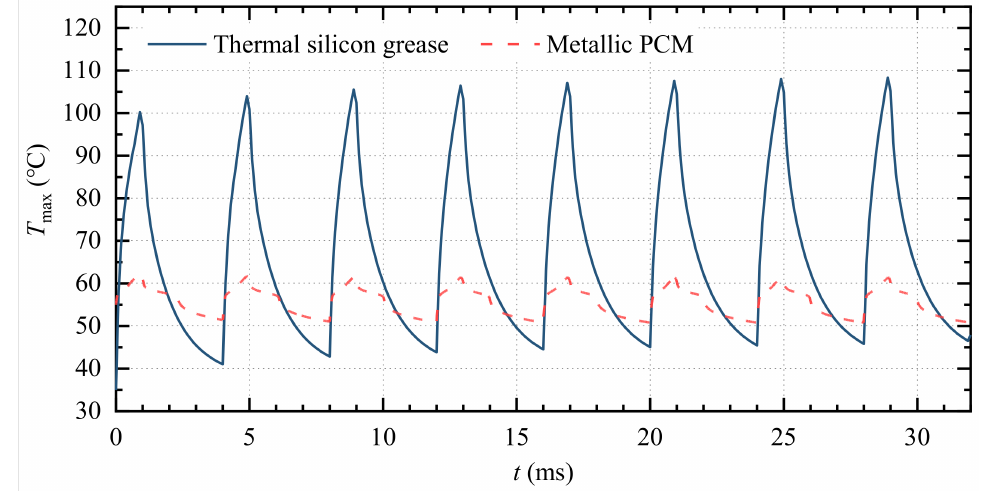
Figure 15. The transient response under heat pluses of the thermal silicon